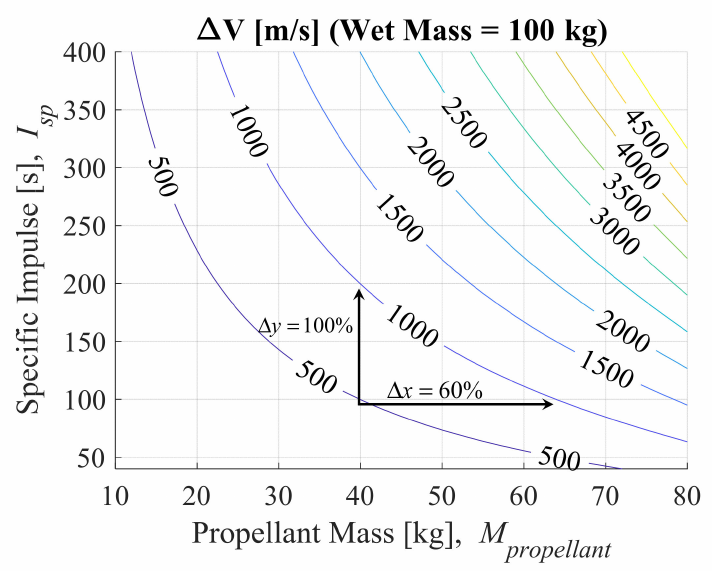
Figure 2. Propellant mass (fraction) has a greater impact on ∆ V than I sp